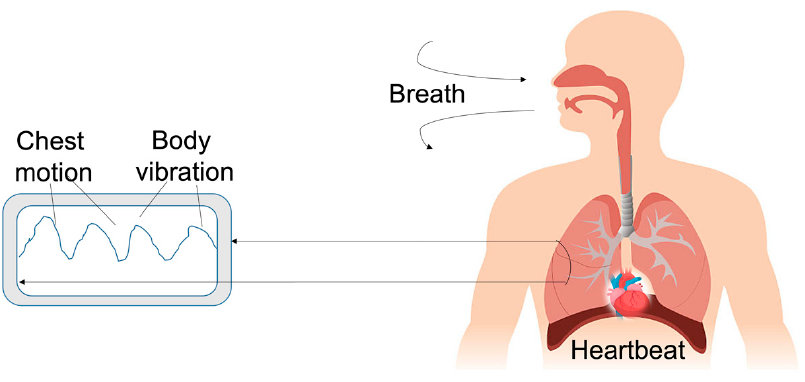
Figure 9. Schematic of the acoustic cardiogram using inaudible acoustic signals to monitor heart-